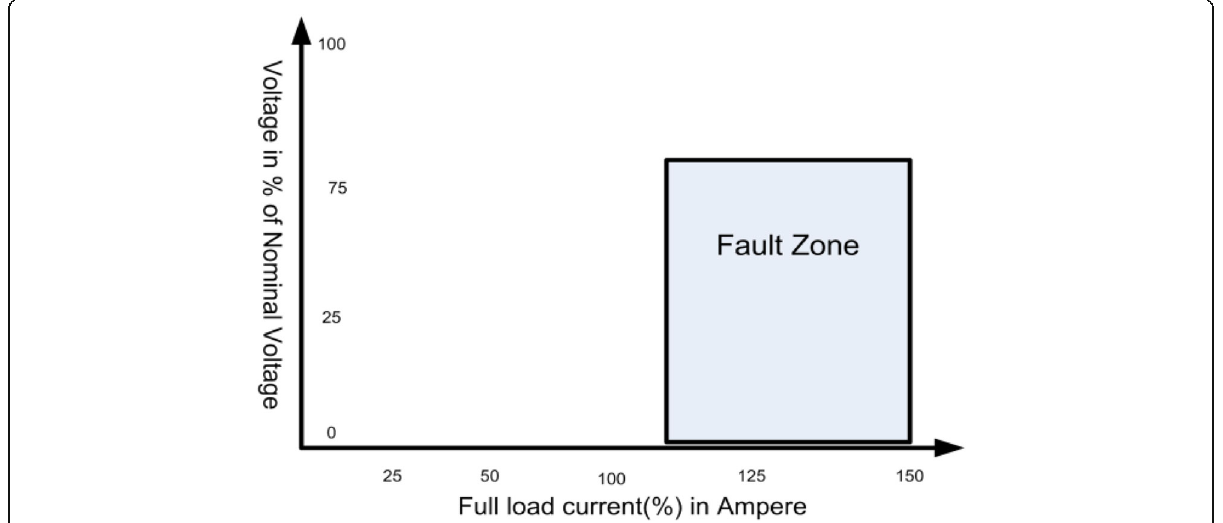
Fig. 8 Voltage-current time inverse relay operating